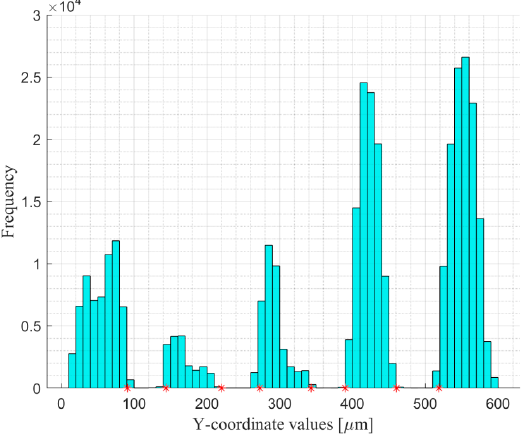
Figure 7. Distribution of the Y coordinates values and the thresholds for outlier detection.